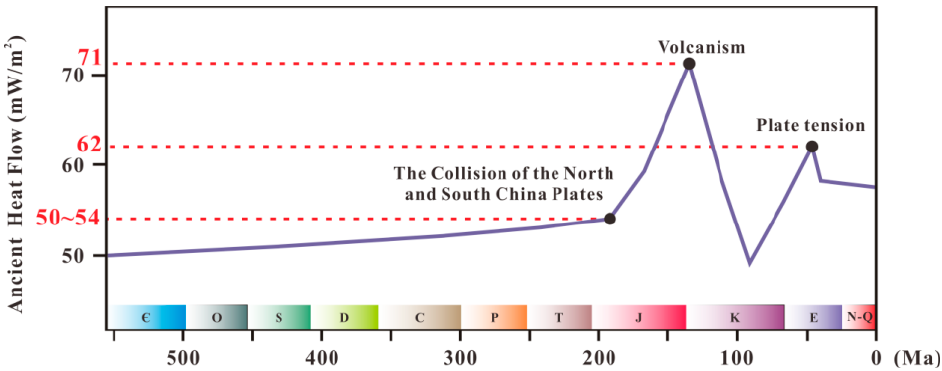
Figure 11. Historical map of ancient heat flow in the Xiuwu Basin (modified from Li et al., 2016).